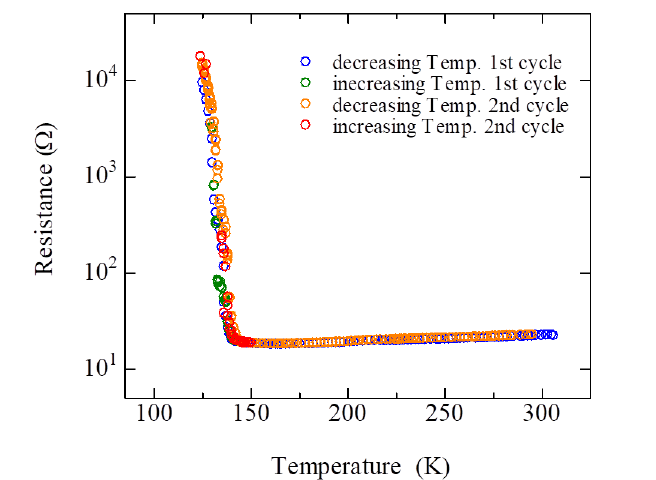
Figure 3. Temperature dependence of four-terminal electrical resistance of α -(BEDT-TTF) 2 I 3 . Both a metallic temperature dependence of the resistance above 140 K and an insulator-like temperature dependence below 140 K are observed clearly. Therefore, the NAC remains stable even at low temperatures. Furthermore, the degradation during the two measurement cycles displayed here is almost negligible, as the results